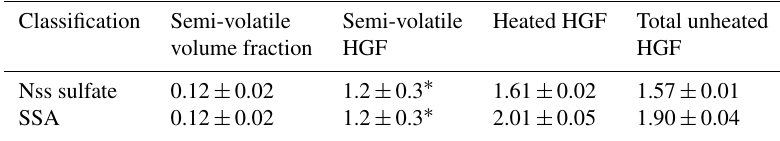
Table 2. Hygroscopicity of volatility-resolved fractions observed in externally mixed marine aerosol.